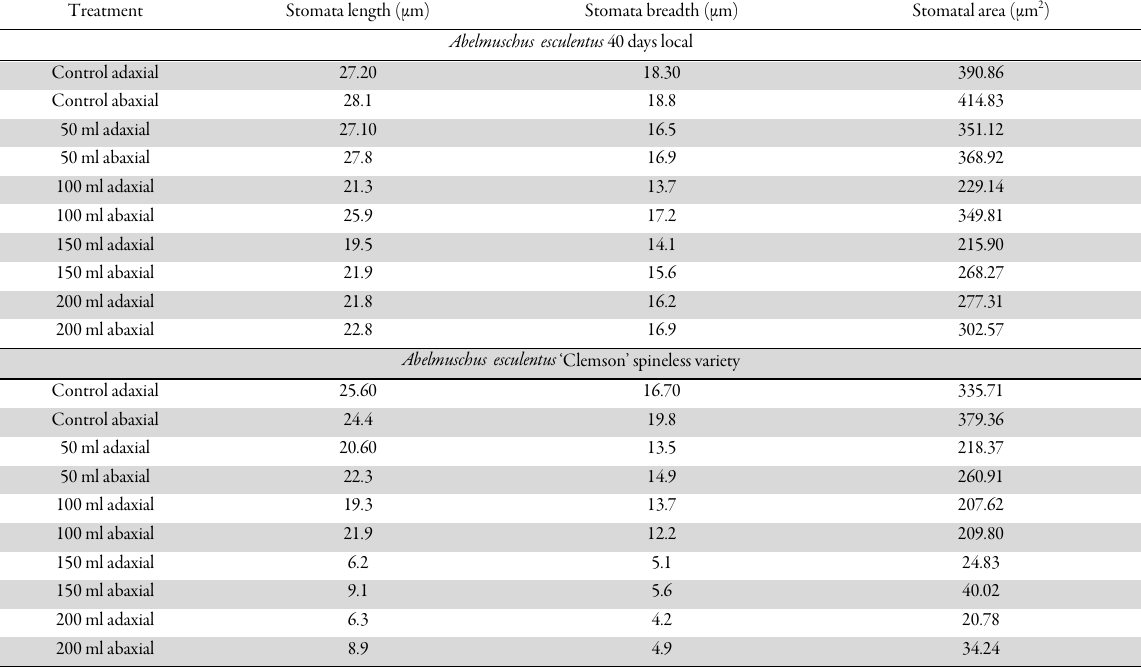
Table 8. Stomatal size as influenced by different concentrations of spent engine oil contamination